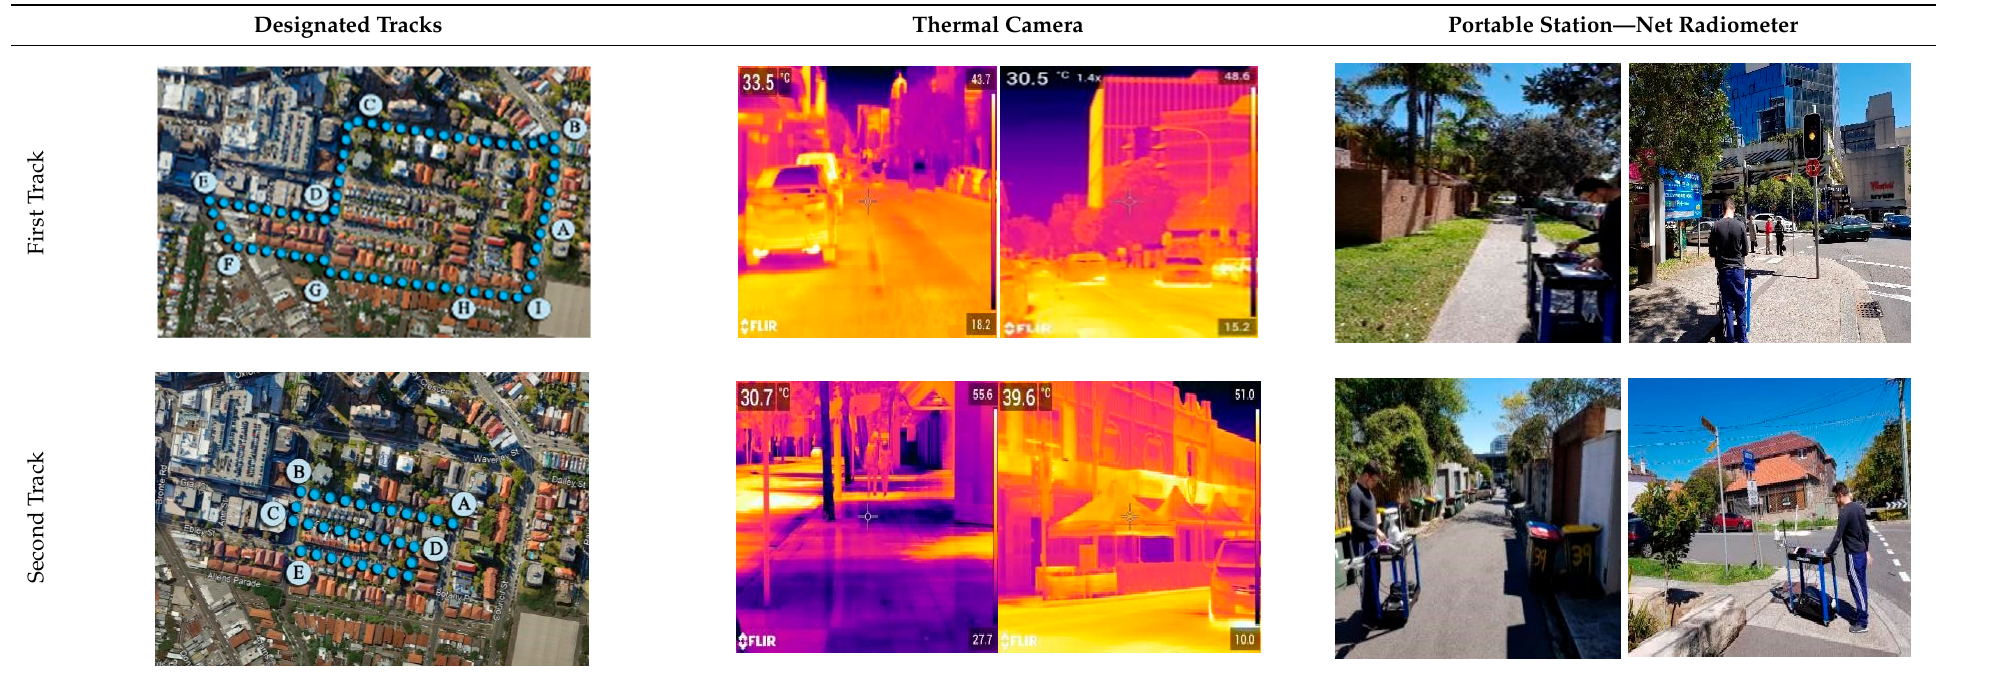
Table 1. Designated tracks, a sample of thermal camera picture, measured variables with their corresponding points.